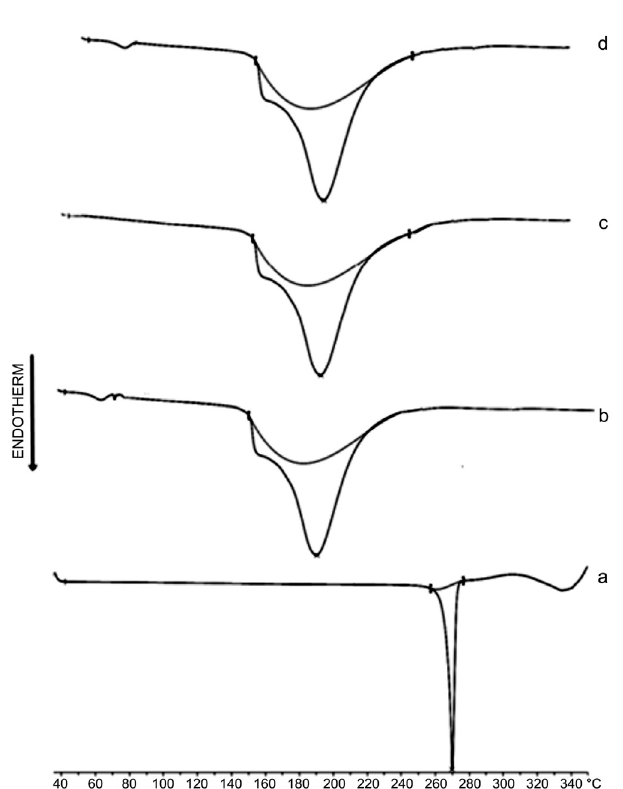
FIGURE 4 - Differential scanning calorimetry curves of ( a ) Raloxifene HCl ( b ) HPMC E5 LV ( c ) Physical mixture